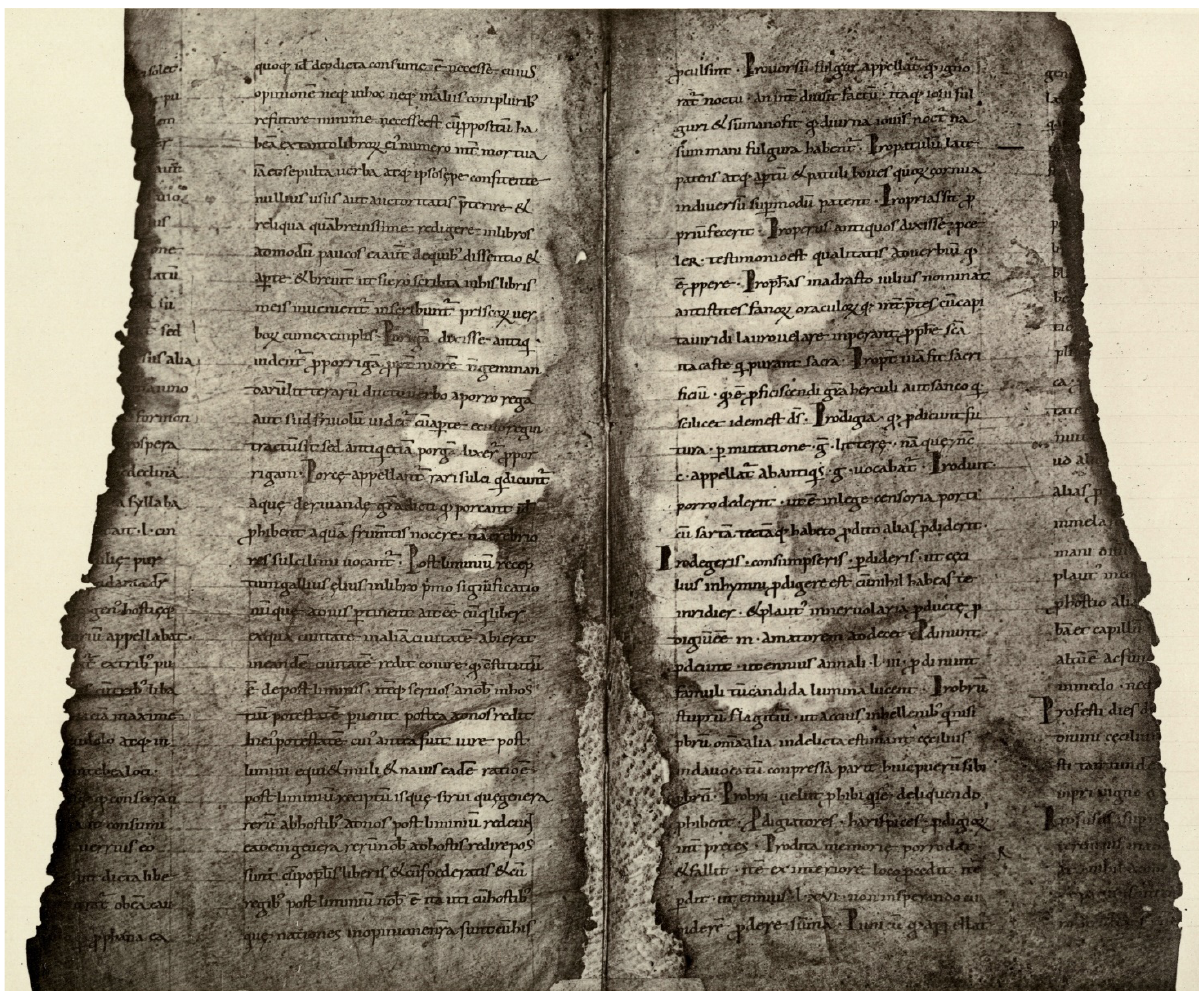
Figure 1. Photograph of two pages from the 11 th century CE manuscript of the work by Festus (‘Codex Festi Farnesianus’, currently preserved in Naples) showing severe damage by fire and water, from Thewrewk de Ponor